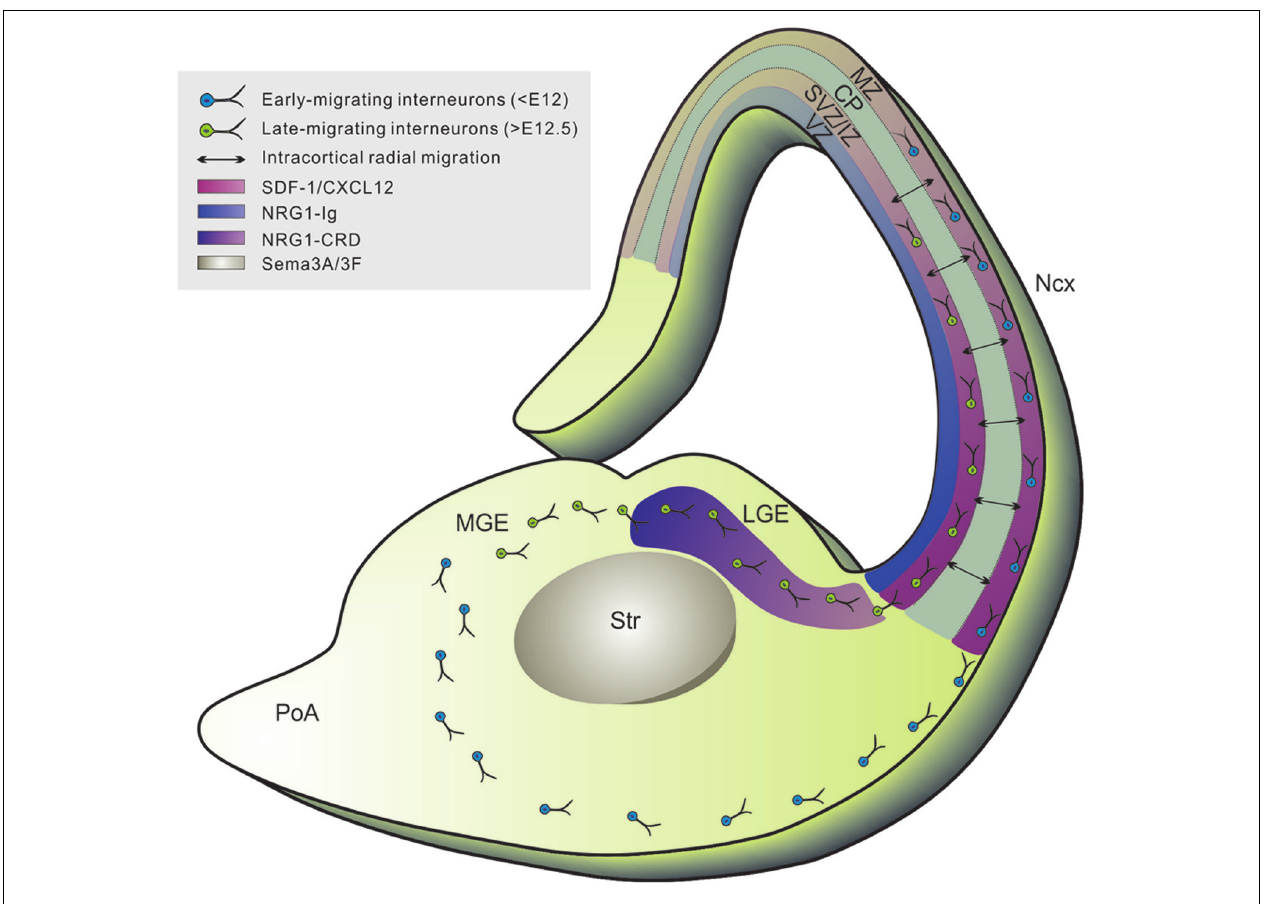
substrates which create a corridor along the SVZ of the LGE for migrating interneurons, leading to the formation of defined migratory routes to the cortex. Upon reaching the cortex, interneurons migrate radially within the CP (black arrows) to settle into their final laminar position (mediated by SDF-1/CXCL12 signaling). VZ, ventricular zone; Str, striatum; LGE, lateral ganglionic eminence; MGE, medial ganglionic eminence; Ncx, neocortex. SDF-1/CXCL12, stromal cell derived factor-1/CXC-motif chemokine 12; NRG1, neuregulin-1; Sema3A/3F, semaphorins 3A and